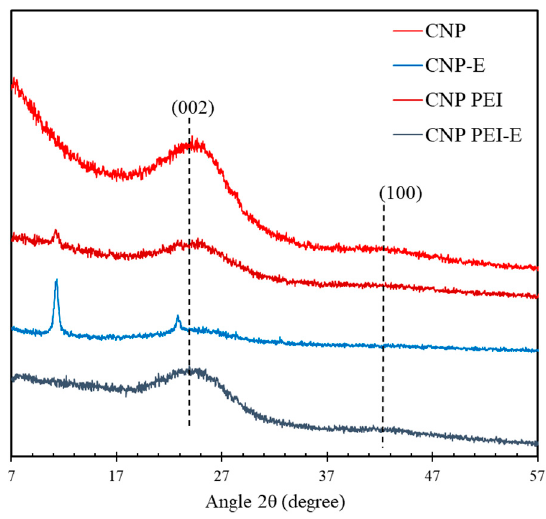
Figure 9. XRD plots of CNP and CNP PEI and their exhausted counterparts.